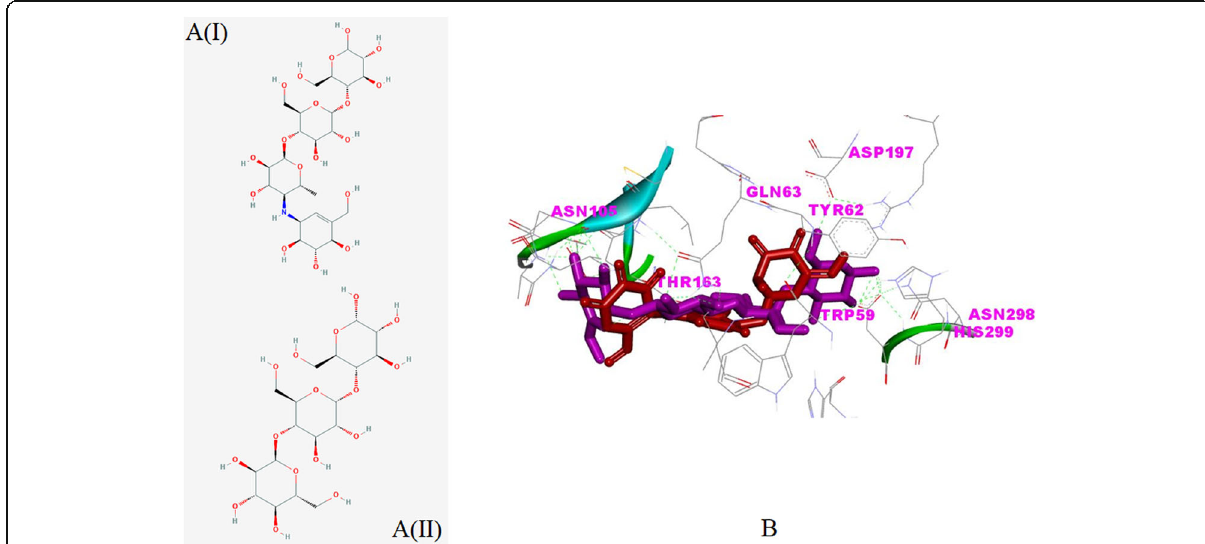
Fig. 2 Molecular docking simultaneous interaction pattern of amylose and acarbose with the active site of HPA (PDB ID: 1HNY) generated using AutoDock Tools 4.2 platform [ A(I) ] 2D structure of Acarbose (PubChem CID: 41774) [ A (II) ] 2D structure of amylose (PubChem CID: 192826) ( B ) 3D docking representation of simultaneously docked compounds (amylose- substrate in red and acarbose- inhibitor in magenta) in the binding pocket showing the hydrogen bond interactions